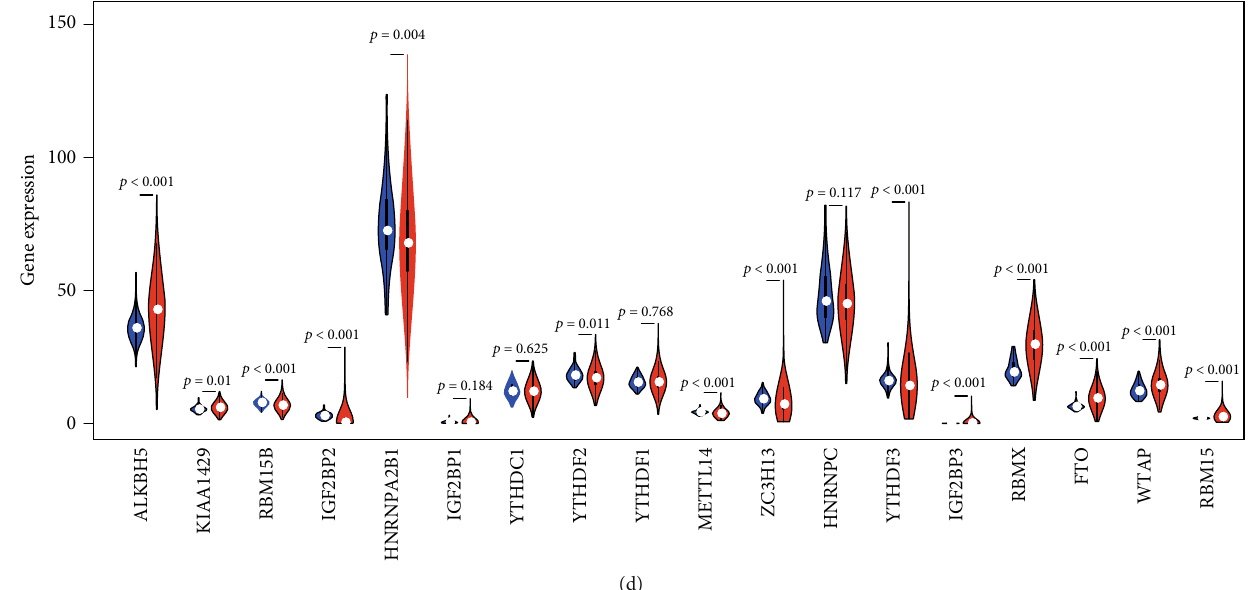
Figure 1: The panorama of m 6 A RNA methylation regulators in ccRCC. (a) The m 6 A RNA methylation process and the regulators involved. (b) Expression levels of 18 m 6 A RNA methylation regulators in ccRCC and normal tissues. The upper tree diagram represents grouping results for the samples, whereas the tree on the left represents cluster analysis results for regulators. Highly expressed genes are represented by a red-colored gradient: the highest the expression, the darker the red tone. In contrast, lowly expressed genes are represented by a green-colored gradient, being the genes with the lowest expression the darker ones. (c) Spearman correlation analysis of the 18 m 6 A RNA methylation regulators in ccRCC and veri fi cation of the correlation between YTHDC1 and RBM15. (d) Vioplot visualizing di ff erentially expressed m 6 A RNA methylation regulators in ccRCC. The x -axis represents di ff erent genes, the y -axis represents gene expression, blue represents normal kidney tissue, and red represents ccRCC tissue. ∗ p < 0 : 05 , ∗∗ p < 0 : 01 , and ∗∗∗ p < 0 : 001